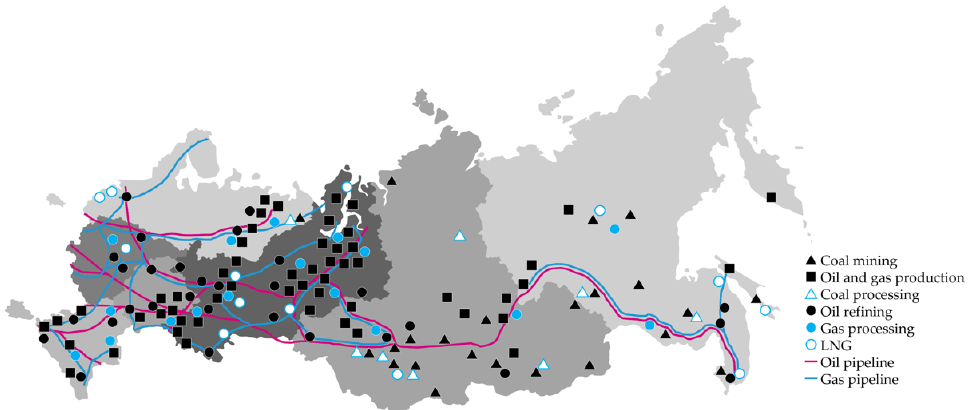
Figure 3. Zonal distribution of the fuel and energy complex of the Russian Federation.